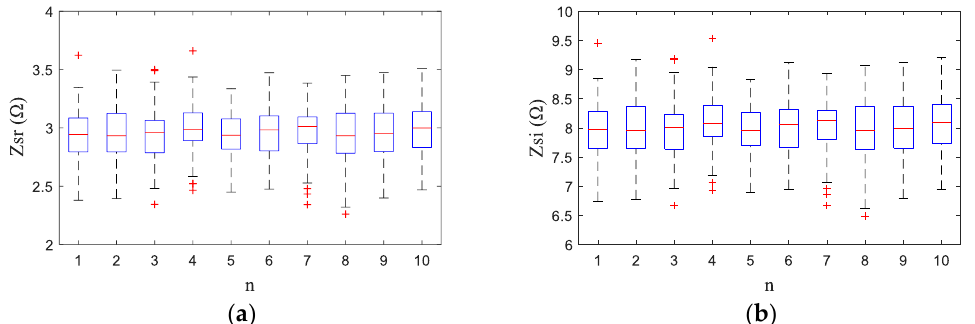
Figure 7. Results of method 4 in simulation I. ( a ) The result of the real part; ( b ) The result of the